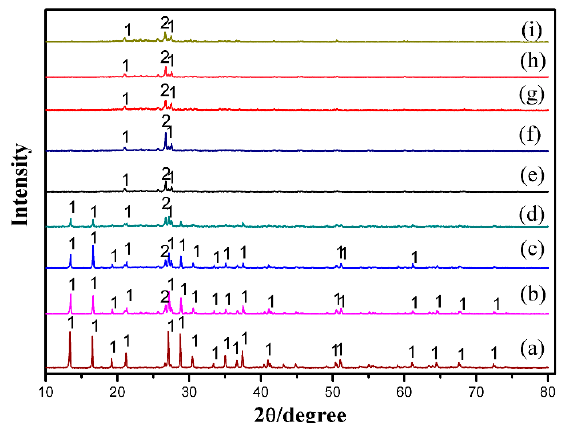
Figure 3. XRD patterns of the leaching residues at different temperatures. 1: Zn 4 Si 2 O 7 (OH) 2 ∙ H 2 O; 2: SiO 2 ; ( a ): material; ( b ): 75 °C; ( c ): 80 °C; ( d ): 85 °C; ( e ): 90 °C; ( f ): 95 °C; ( g ): 100 °C; ( h ): 104 °C; and ( i ): 108 °C.